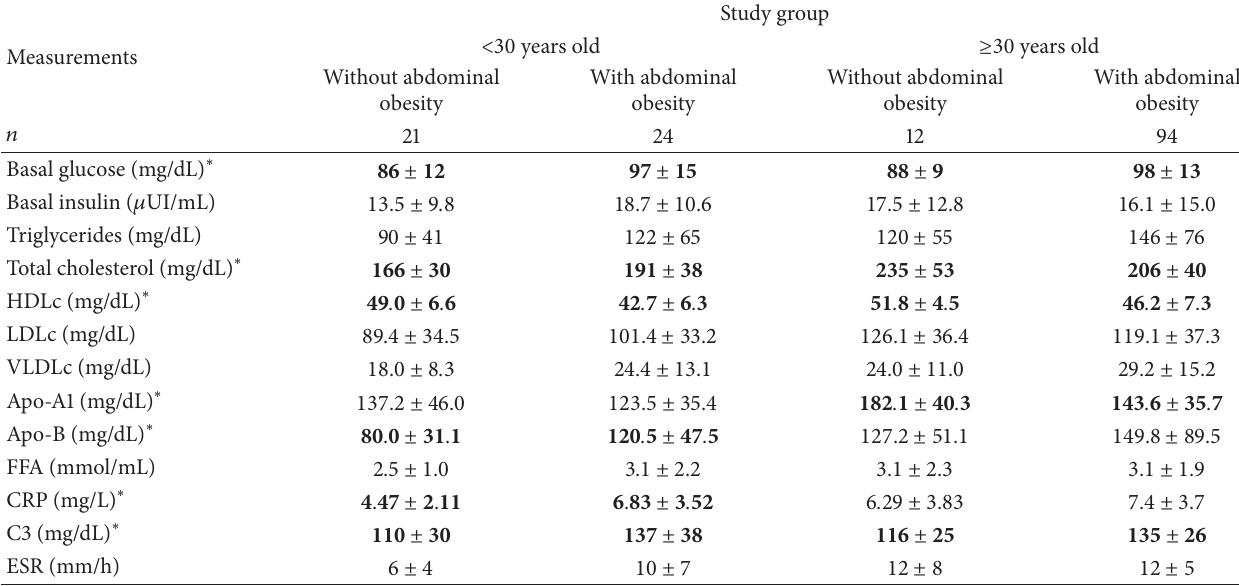
Table 2: Metabolic and inflammation markers in individuals included in the